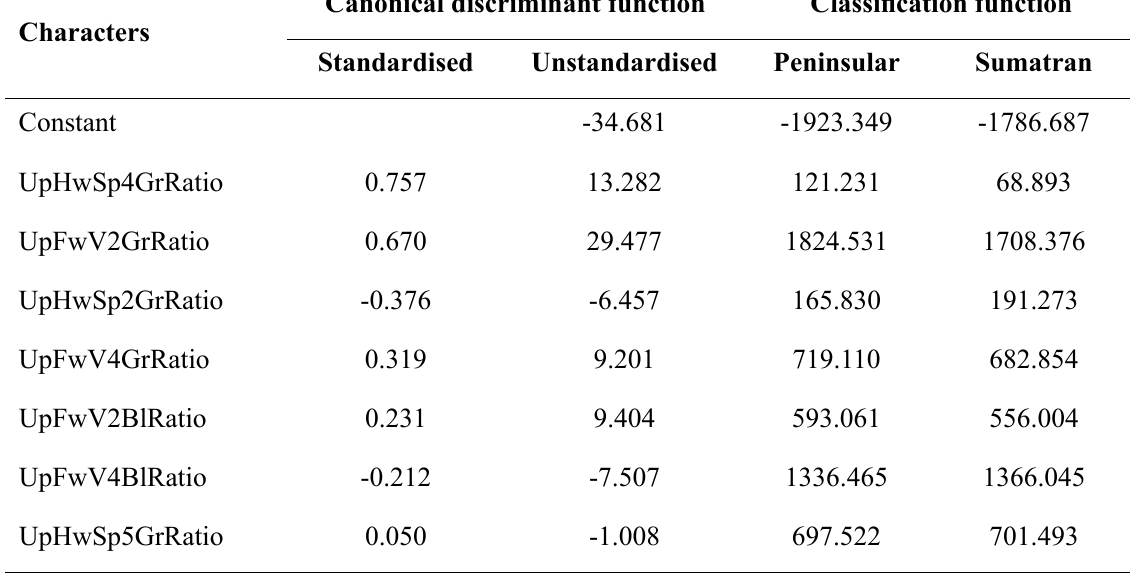
Table 3. Coefficients and constants for each ratio character in the cross-validated canonical discriminant and classification functions of female birdwings from Sumatra and Peninsular